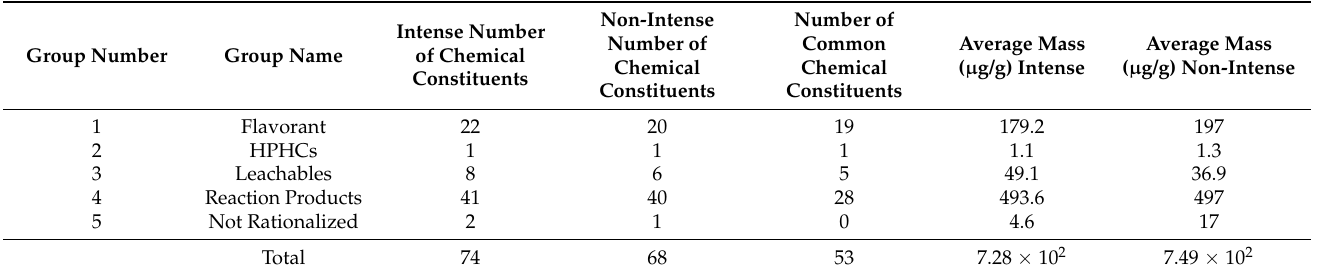
Table 5. Summary of non-targeted analyses of Me3 aerosol constituents detected by GC and/or LC NTA methods using both puffing regimens.